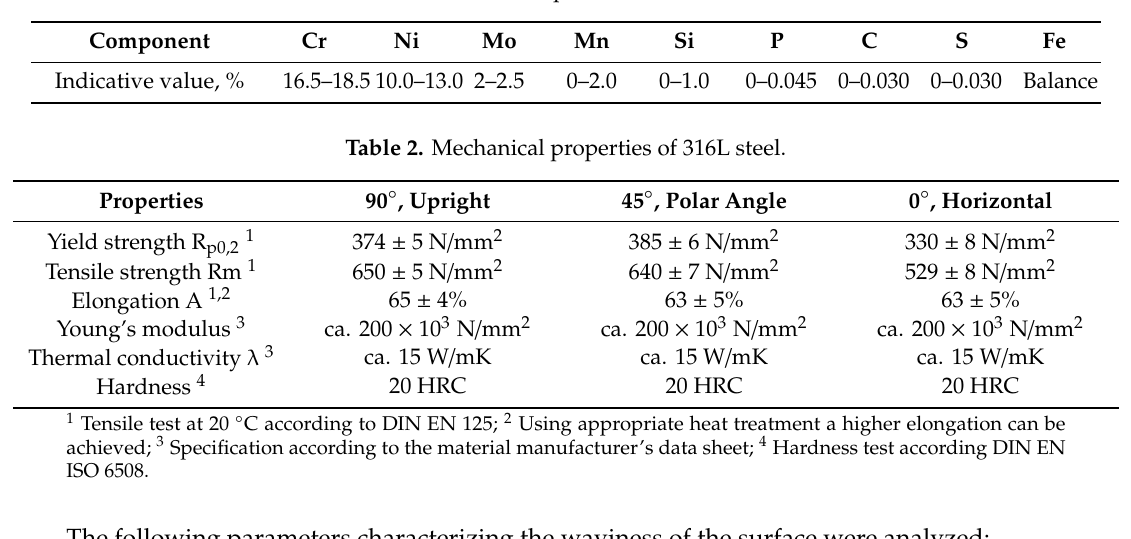
Figure 3. Examined surfaces. Table 1. Chemical composition of 316L material.